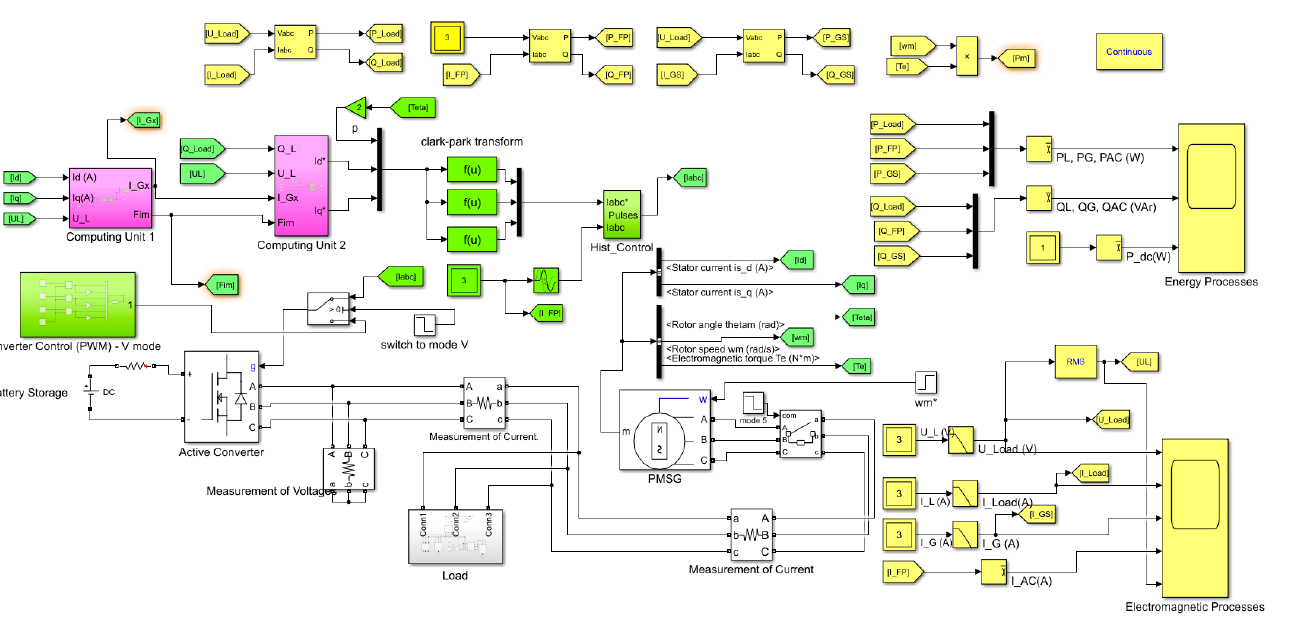
Figure 12. Autonomous hybrid ship power plant system with PMSG in parallel topology with the control system. Model implemented in the Matlab-Simulink program.